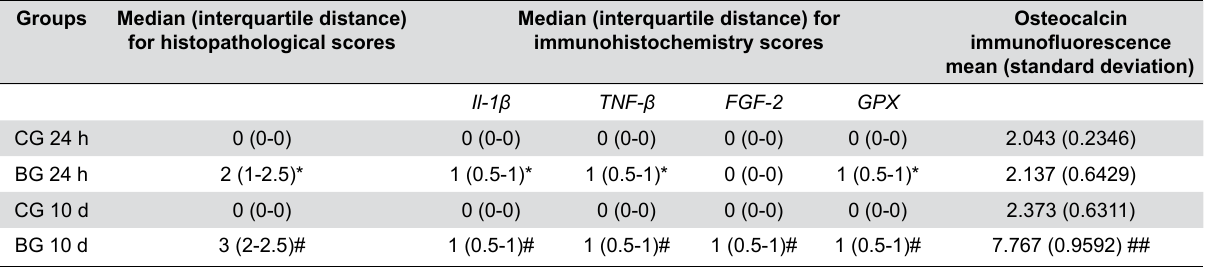
Figure 1- Histopathological analysis: CG 24h (control group 24 hours); CG 10d (control group 10 days); BG 24h (bleached group 24 hours); BG 10d (bleached group 10 days). d=dentin, n=necrosis; *= Mononuclear moderate inflammatory infiltrate; **= Intense inflammatory infiltrate; short arrow: lymphocyte: double arrow: Table 1- Histopathological and immunohistochemistry scores. Immunofluorescence analysis - mean (standard deviation)